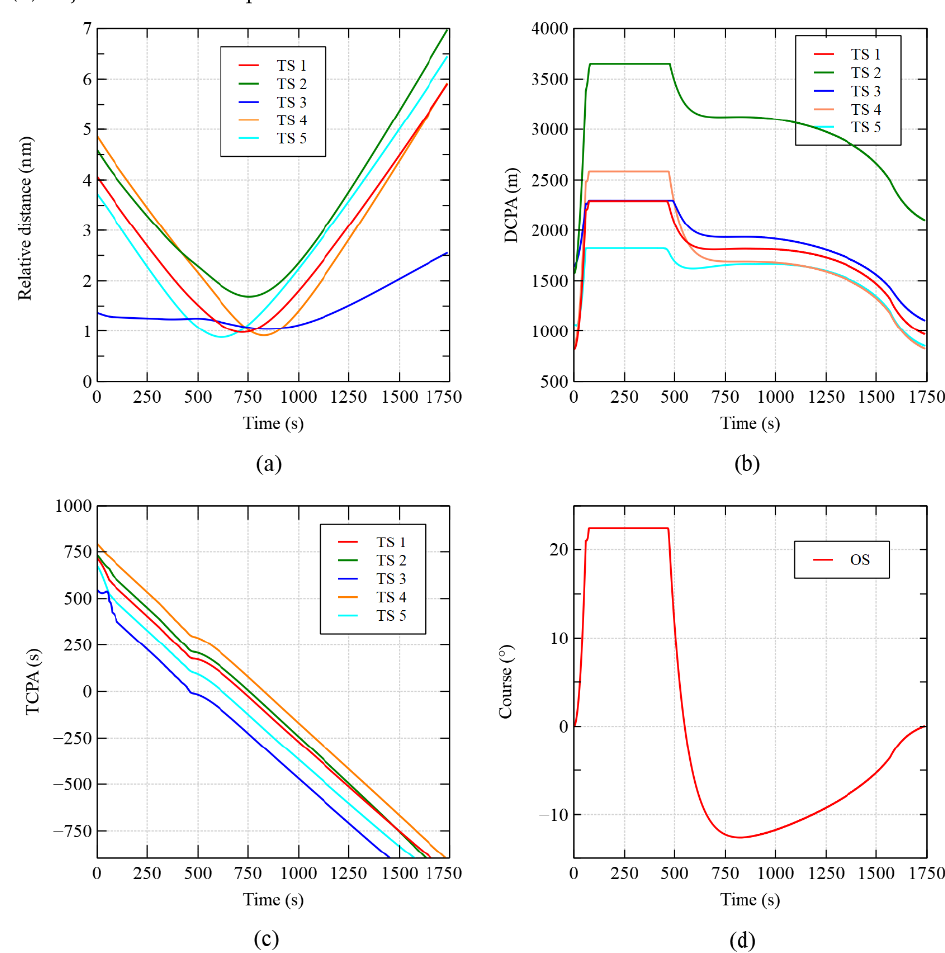
Figure 13. Real-time parameter changes under six-ship encounter situation. ( a ) Relative distance between OS and TSs; ( b ) DCPA between OS and TSs; ( c ) TCPA between OS and TSs; ( d ) the course of OS.